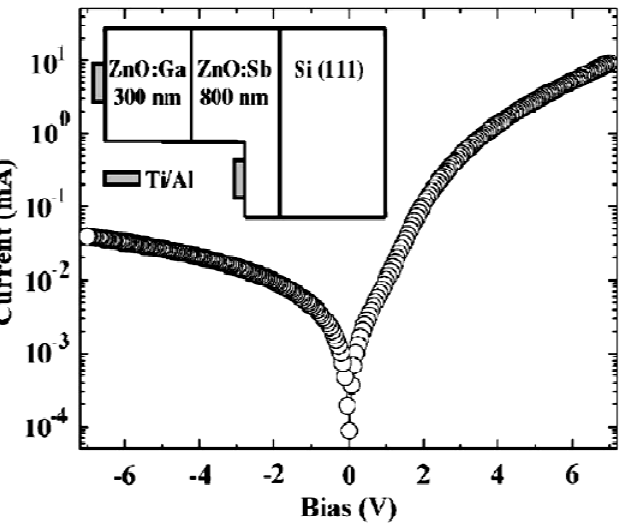
Figure 12. Dark I - V curve of a ZnO:Ga/ZnO:Sb homojunction. Absolute value of current is plotted. Inset: Cross-sectional view of the diode. Shaded rectangles represent Ti/Al contacts